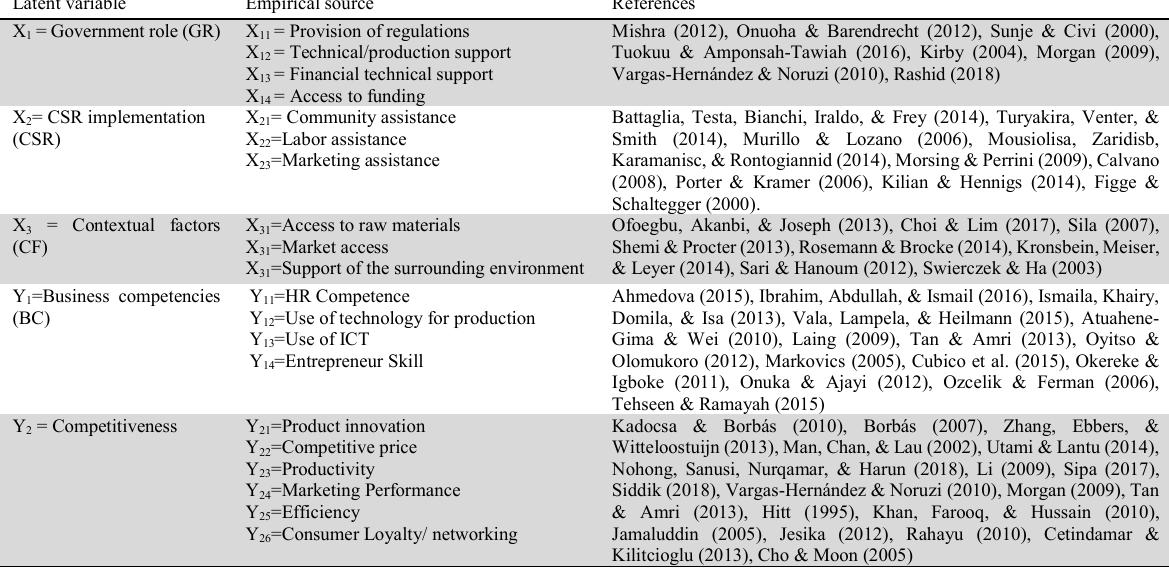
Latent Variables, Variable Indicators and Empirical Sources of